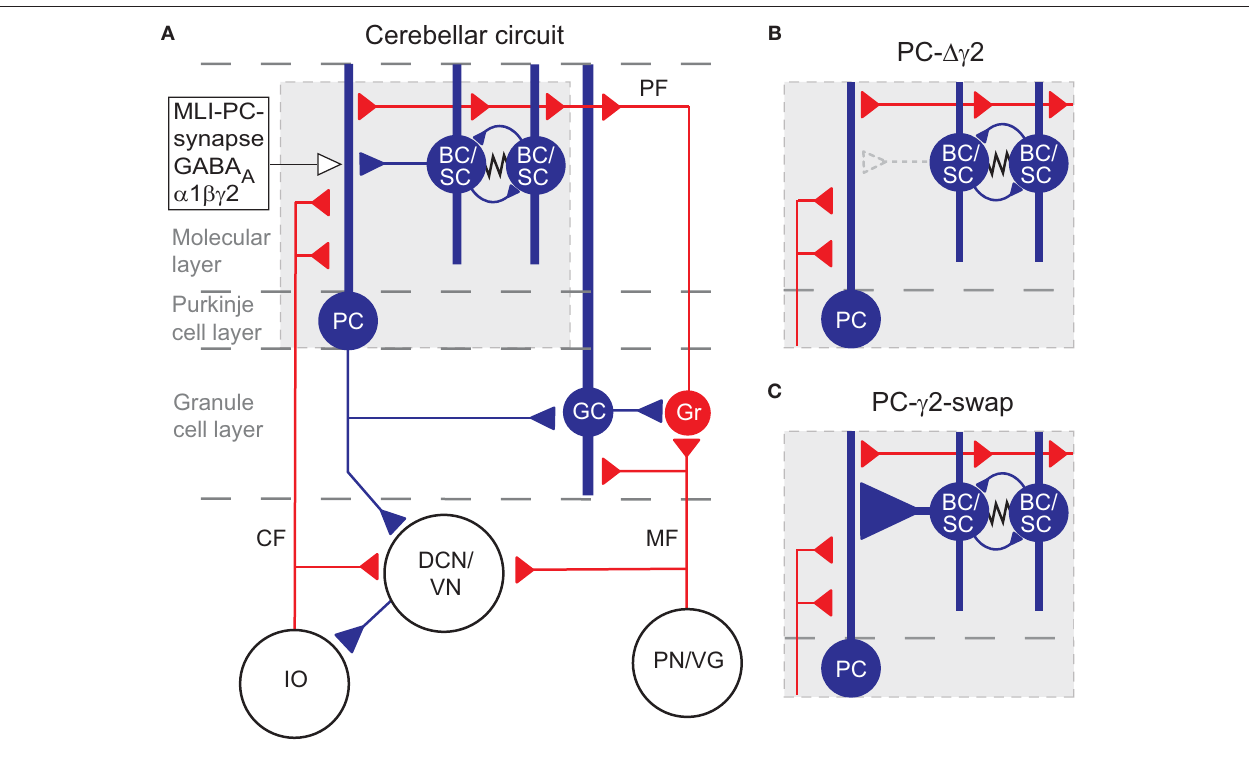
FIGURE 1 | The cerebellar circuitry and the interventions at the MLI-Purkinje cell synapses. Excitatory cells are shown in red, inhibitory cells are shown in blue. (A) All cells in the cortex are inhibitory apart from granule cells (Gr) which give rise to parallel fi bres (PF), and unipolar brush cells (not shown). The cerebellar cortex receives excitatory input via mossy fi bres (MF) and climbing fi bres (CF). The only output of the cortex is via Purkinje cells (PC), which project to the deep cerebellar nuclei (DCN) and vestibular nuclei (VN). The